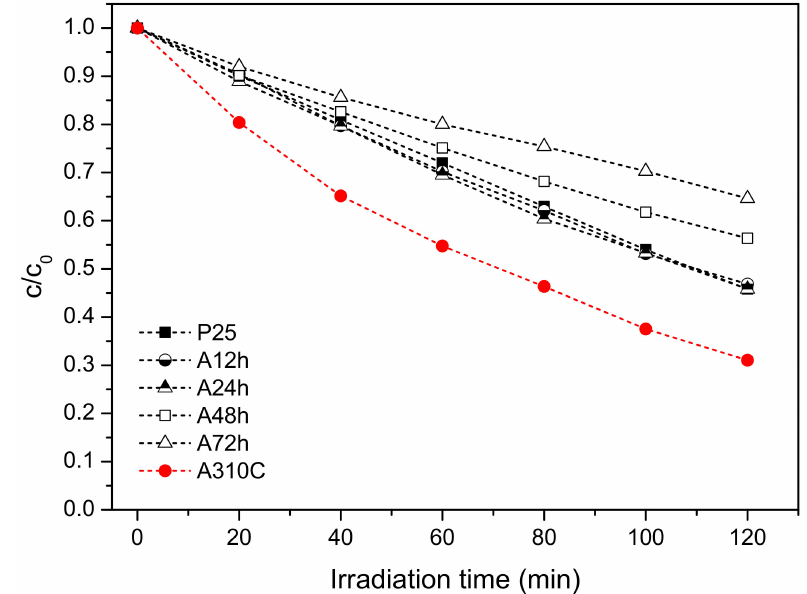
Figure 6. Photocatalytic degradation of phenol using di ff erent TiO 2 NPs treated hydrothermally and P25 TiO 2 (as reference photocatalyst) under UV-A light irradiation. The aqueous dispersions contained TiO 2 NPs with a concentration of 0.5 mg / mL. The initial phenol concentration was 0.5